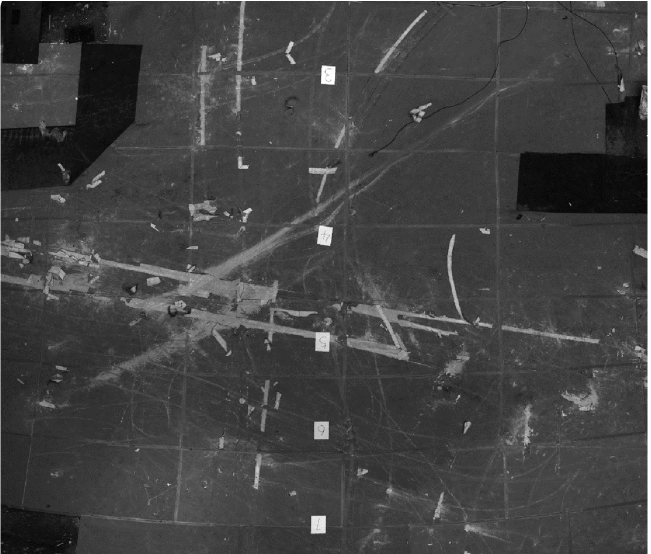
Figure 29. OCPSI mode: effective image.